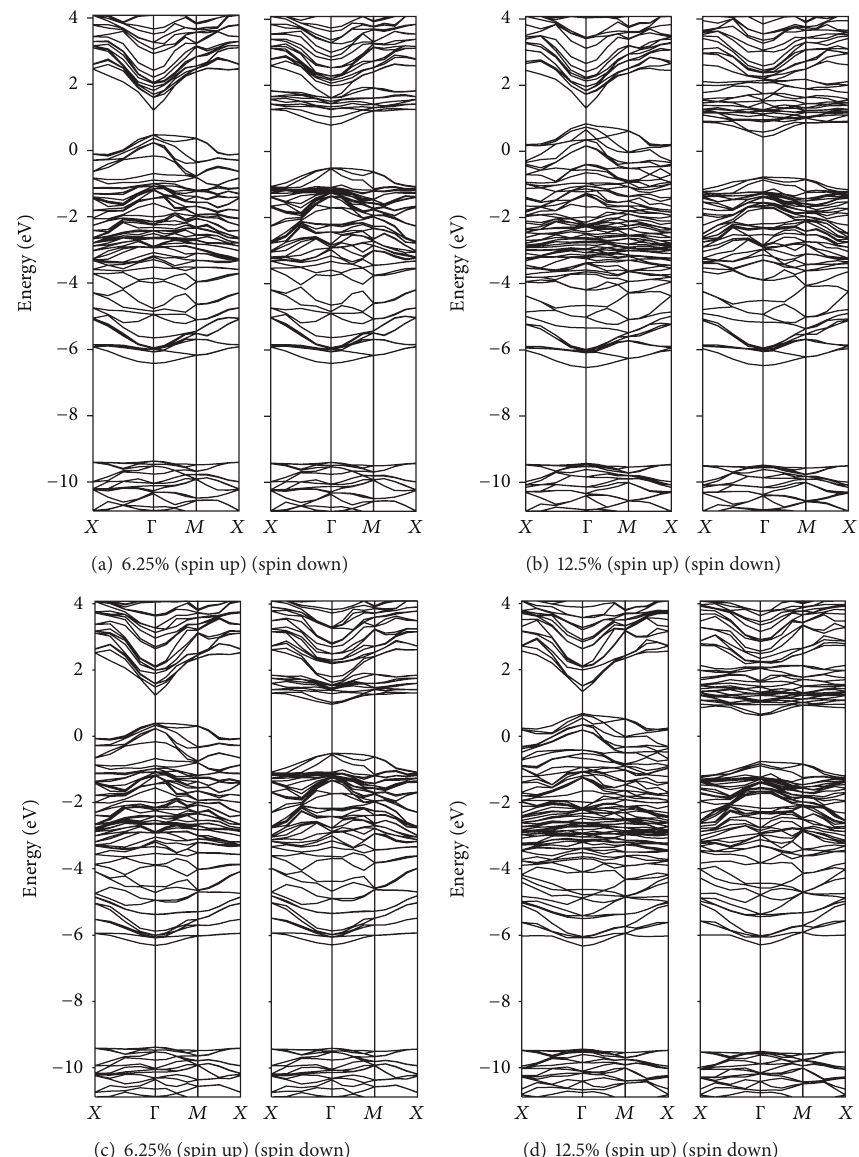
Figure 4: Band structures for Ga-rich ( Al 1−𝑦 Mn 𝑦 ) GaP 2 of (a) and (b) and Al-rich Al ( Ga 1−𝑦 Mn 𝑦 ) P 2 of (c) and (d) with 𝑦 = 0.0625 and 0.125 in the FM state. The Fermi level is set to